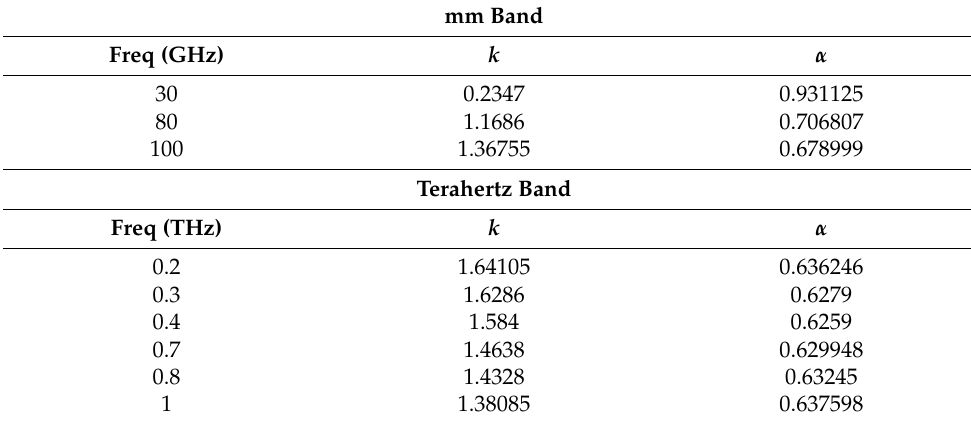
Table 2. ITU parameters for attenuation